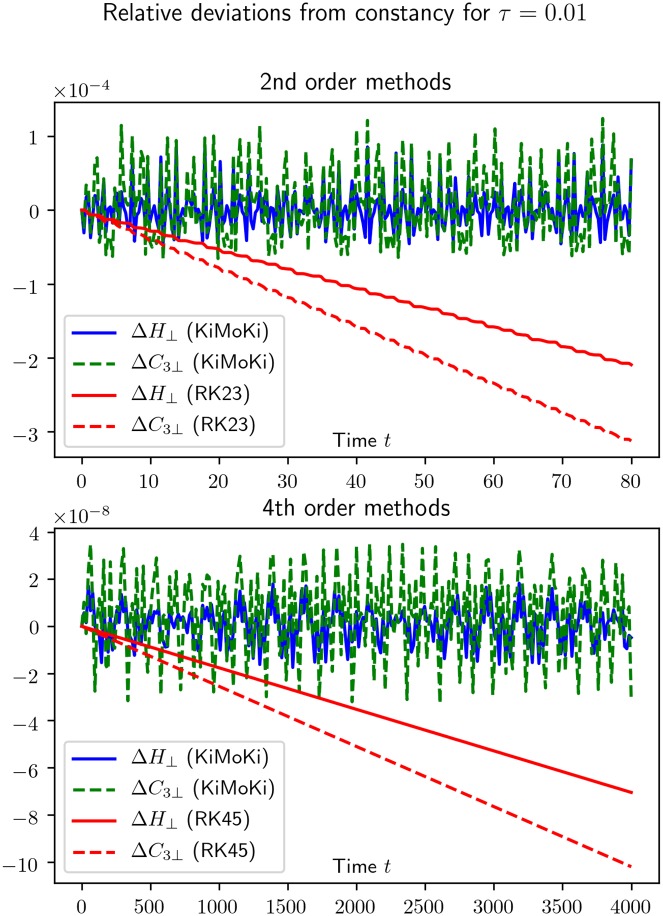
See the caption to Fig 1.